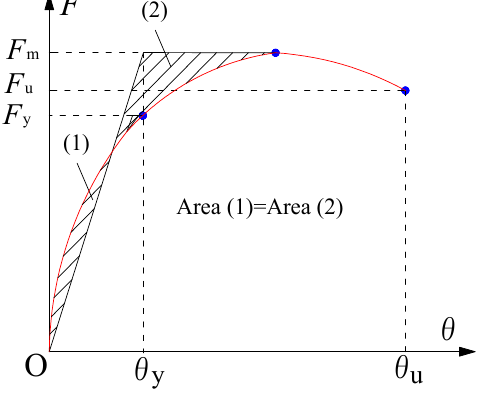
Figure 9. Definition of F y , F m and F u . Table 6. Strength and deformation capacity of specimens.